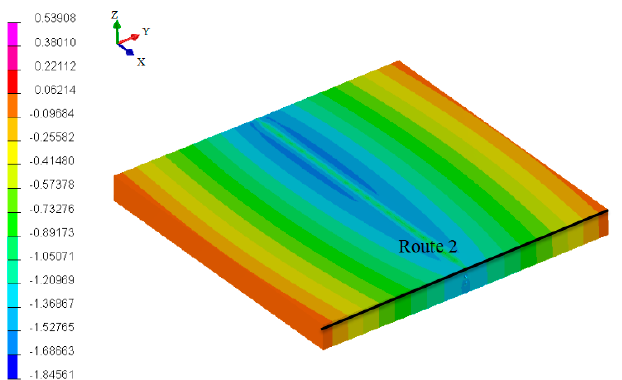
Figure 12. Colored map of the angular distortion in simulation. The values on the left represent the displacement, of which positive values indicate distortion in the positive direction of the Z axis and negative values indicate distortion in the negative direction of Z axis. Different colors indicate different distortion values, and route 2 (black line) was chosen to compare the displacement between simulation and experiment.